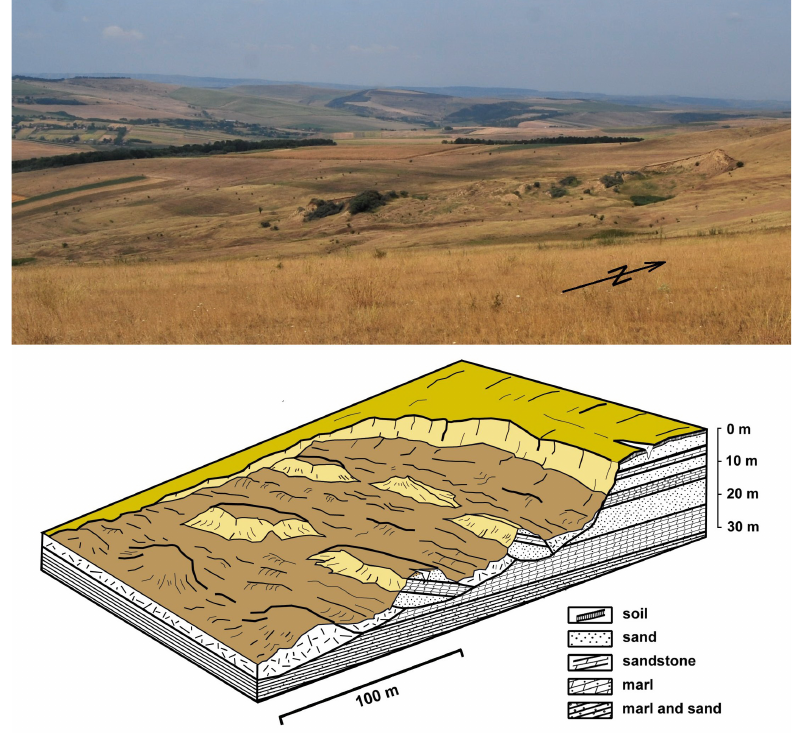
Fig. 2. Deep-seated landslide ( glimee ) in the Transylvanian Plateau (C˘apu¸su de Câmpie sector) and associated block diagram.